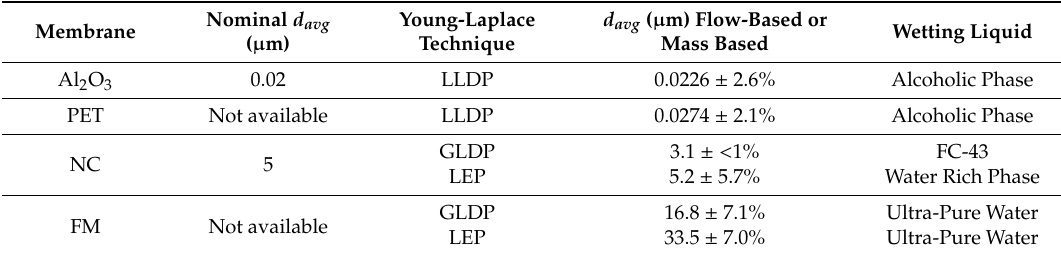
Table 2. Mean pore diameters ( d avg ) obtained via FCP and LEP for the four membranes